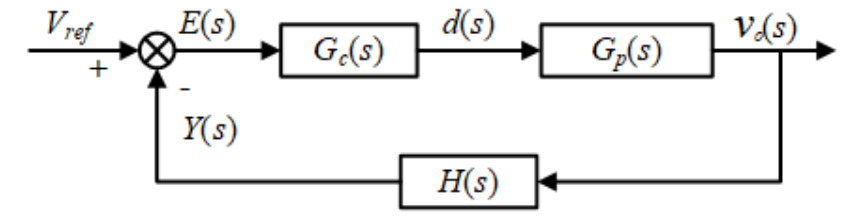
Figure 10. Forward control loop diagram.